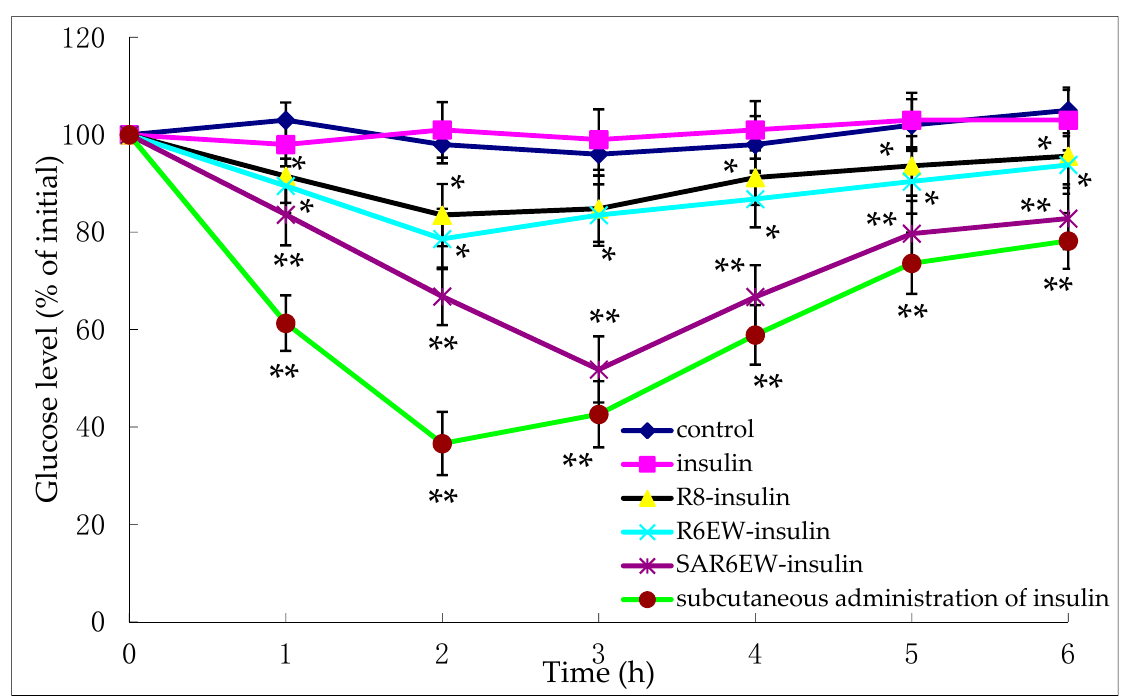
Figure 7. Plasma glucose levels (% of initial) after oral administration of the following compounds in diabetic rats (mean ± SD, n = 3, *: p < 0.05, **: p < 0.01 vs. control).